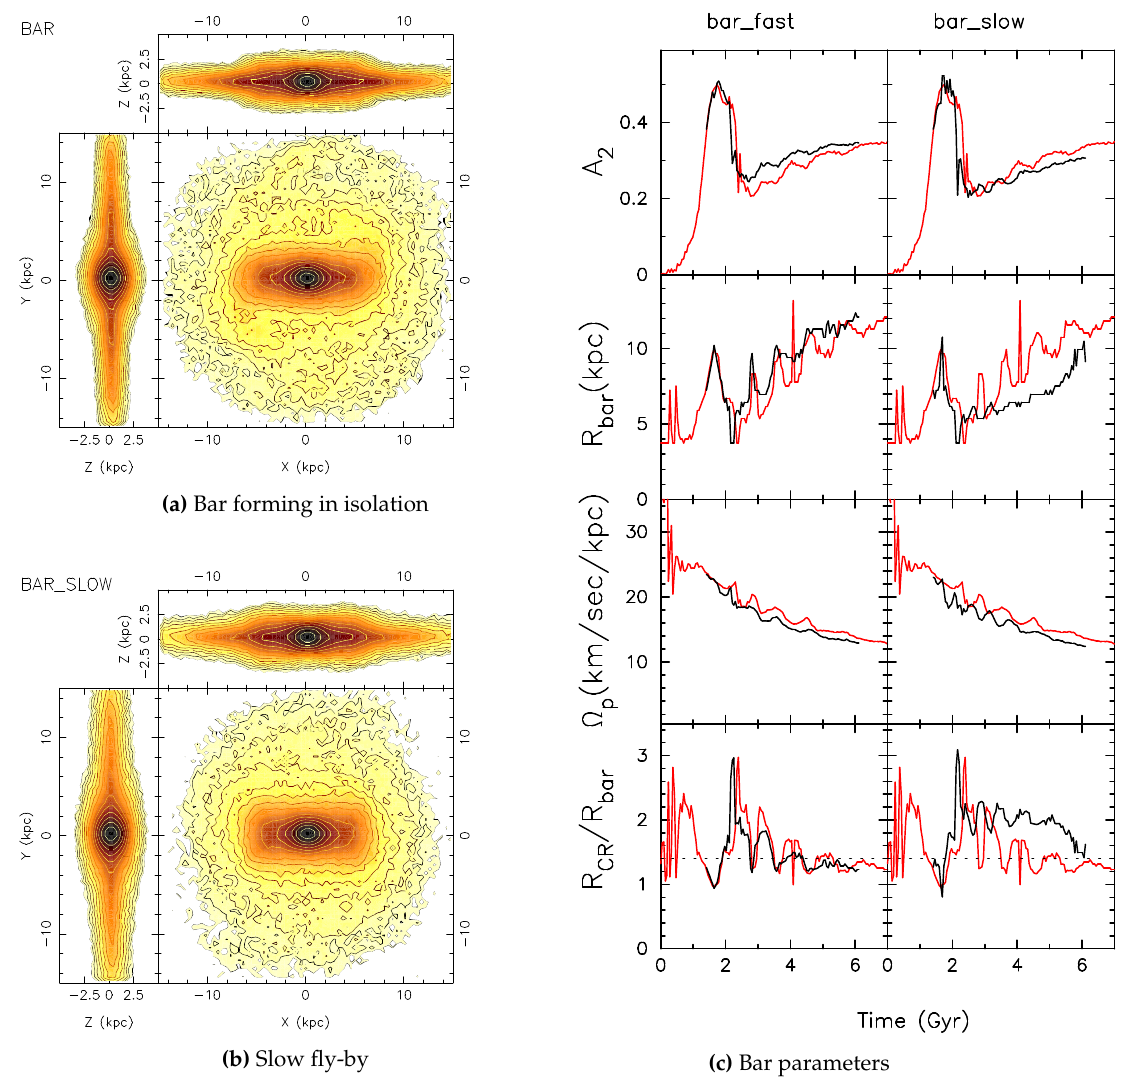
Figure 1. Left : Stellar density maps in three spatial projections of the simulation with bar in isolation ( bar case ). The original simulation is plotted on the top left, and below we plot the resulting galaxy after the slow interaction. The time shown is τ = 4.18 Gyr, in both cases, i.e. , after the big drop in bar strength, related to the bar buckling, and sometime to give the bar time to resume its evolution. Right : Time evolution of bar parameters for the fast and slow encounter. The red line represents the evolution of the original galaxy in isolation. ( a ): Bar forming in isolation; ( b ): Slow fly-by; ( c ): Bar